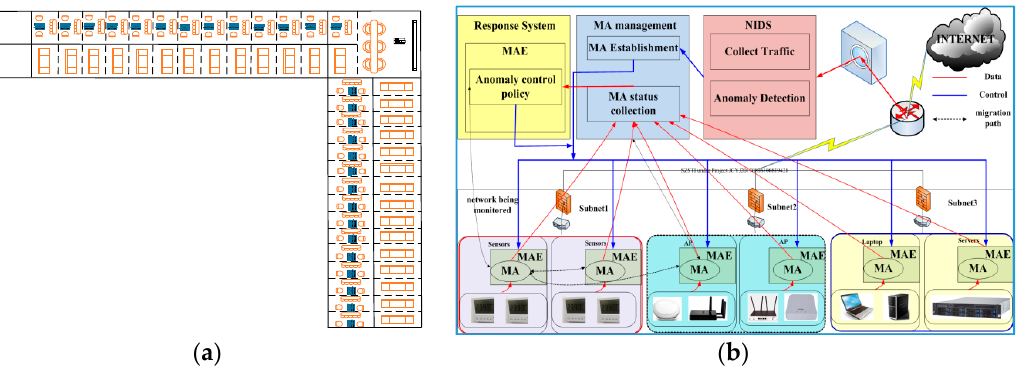
Figure 1. Introduction to Intelligent Maintenance and Lightweight Anomaly Detection System (IMLADS): ( a ) architecture of the building; ( b ) framework of IMLADS.